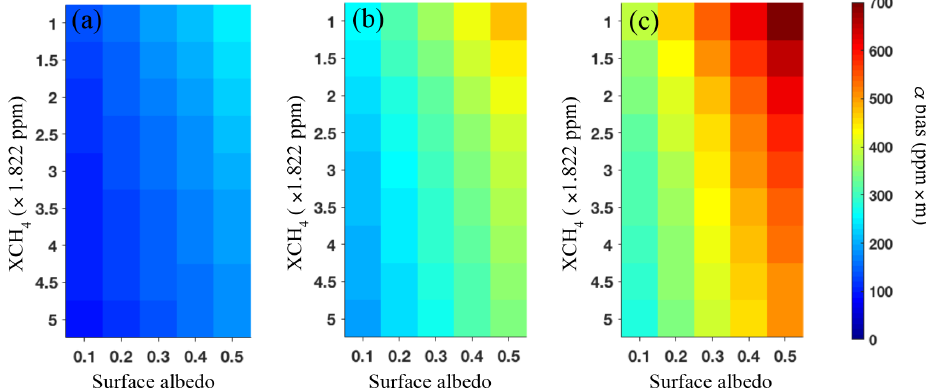
Figure 6. Bias in α as a function of XCH 4 and surface albedo for (a) AOD = 0 . 1, (b) AOD = 0 . 2, and (c) AOD = 0 .